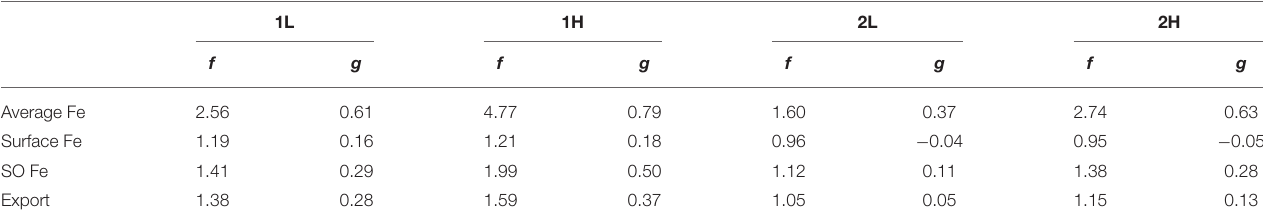
TABLE 5 | Feedback factors f and gain g for the four chosen metrics in the four model runs with prognostic ligands 1L , 1H , 2L , and 2H